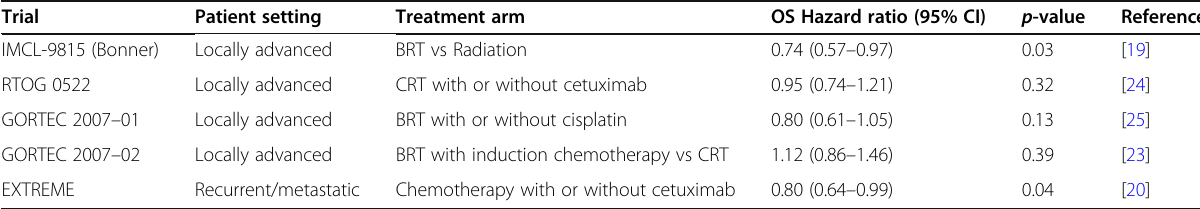
Table 1 The results of phase 3 trials evaluating the efficacy of cetuximab to SCCHN Trial Patient setting Reference IMCL-9815 (Bonner)